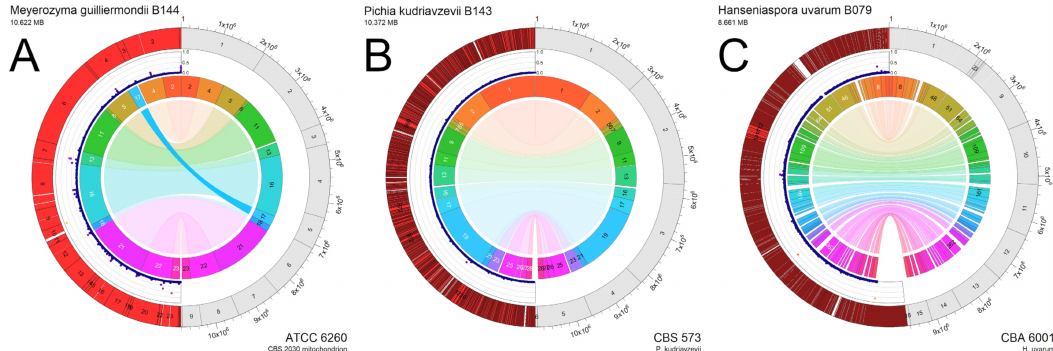
Figure 4. ( A – C ). Genomic alignments of three non-conventional yeast isolates, Hanseniaspora uvarum B079 , Pichia kudriavzevii B143 , Meyerozyma guilliermondii B144 , against suitable reference genomes. The left part (red and very dark red) of the outer ring represents the snail yeast isolates, while the right parts (in grey) represent scaffolds of the reference genomes. The draft genomes were ordered using Mauve Contig Mover (MCM); for snail yeast genomes the extent of contigs > 10 kb are shown in bright red; contigs > 10 kb (100 kb for B079) are identified by numbers; alignment gaps are shown if they were > 2.5 kb. In the middle ring, the divergence of the draft genomes to reference genomes (calculated based on consecutive 1 kb windows) is shown (indicating low divergence, i.e., high sequence identity). Only windows with at least 90% nucleotide coverage (900 nt) are shown; points are also colour-coded with higher-divergence tending towards yellow. The Inner ring shows Locally Collinear Blocks (LCB) with a minimum length of 50 kb. LCBs are colour-coded and enumerated; transparency of genomic links connecting LCBs on either genome decreases as mismatches between relative positions on each genome increases (i.e., translocation events are less